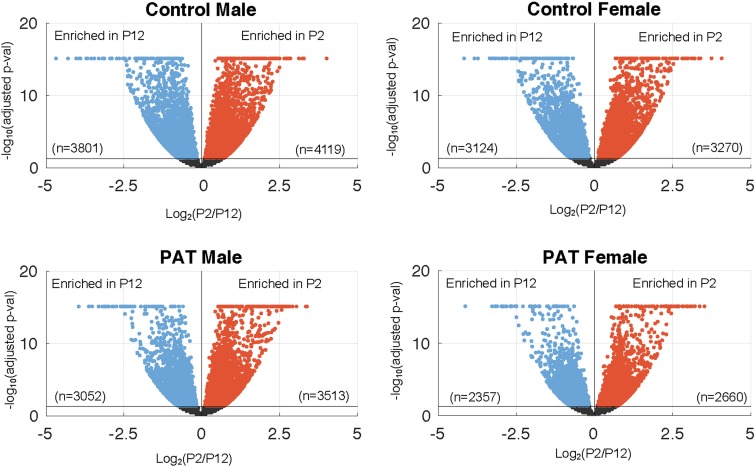
Differential ileal gene expression maturation between P2 and P12 in control and PAT mice, as shown in volcano plots.In the controls, a total of 7920 genes (for males) and 6394 (for females) showed significant maturation between P2 and P12, (adjusted p<0.05 based on DESeq2 differential expression analysis). The PAT mice received their antibiotic course between P5-10, and the number of genes maturing between P2 and P12 fell to 6565 in males, 17% less than in controls, and to 5017 in females, 21% less than in controls. Visualization of DESeq2 differences maximizes at 15 (-log10 (adjusted p values)).